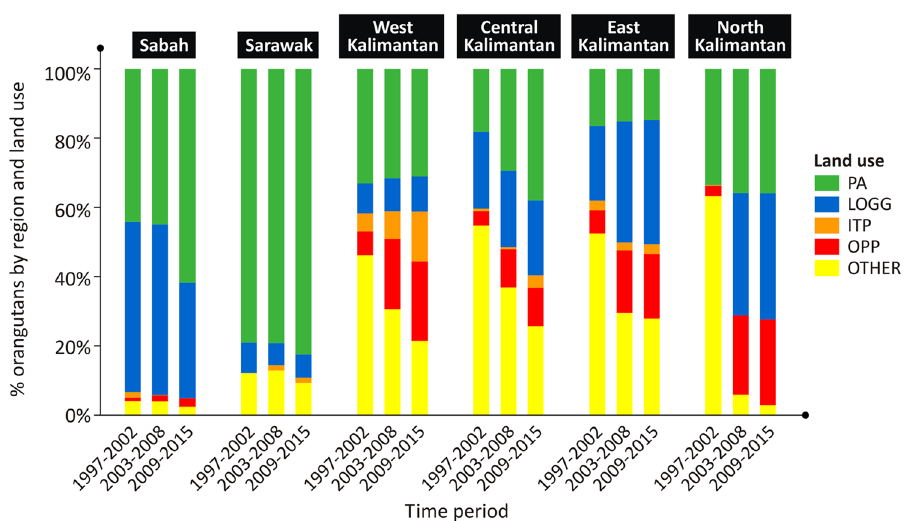
Figure 2. Distributions of orangutan populations across different regions and land uses in three consecutive time periods between 1997 and 2015. Land use appraised include protected areas (PA), logging concessions on natural forest (LOGG), industrial timber plantation concessions (ITP), oil palm concessions (OPP), and outside protected areas, infrastructure and urban areas and without concession